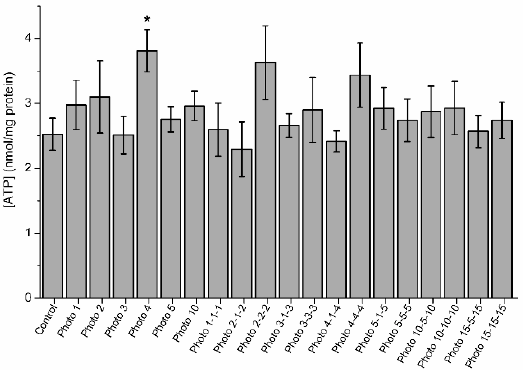
Figure 6. Intracellular ATP levels in control and irradiated samples. The superscript (*) means significant differences ( p ≤ 0.05) between the control and different light-stimulation patterns. Data are shown as mean ± SEM of nine independent experiments.